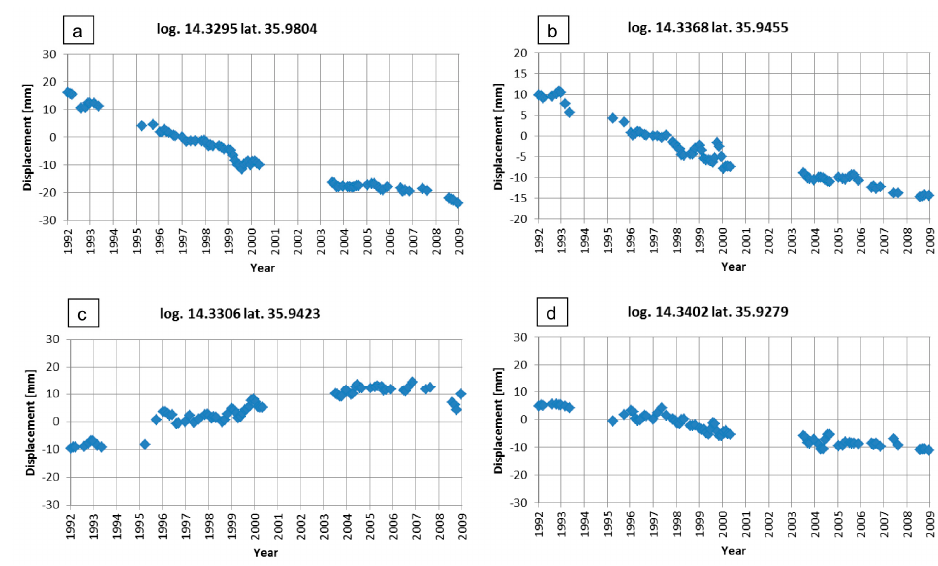
Figure 6. ERS (on the left) and ENVISAT (on the right) time series of four homologous PS located at ( a ) Marfa Ridge; ( b ) Rdum Majjiesa; ( c ) Ras Il-Wahx; ( d ) Il-Qarraba.